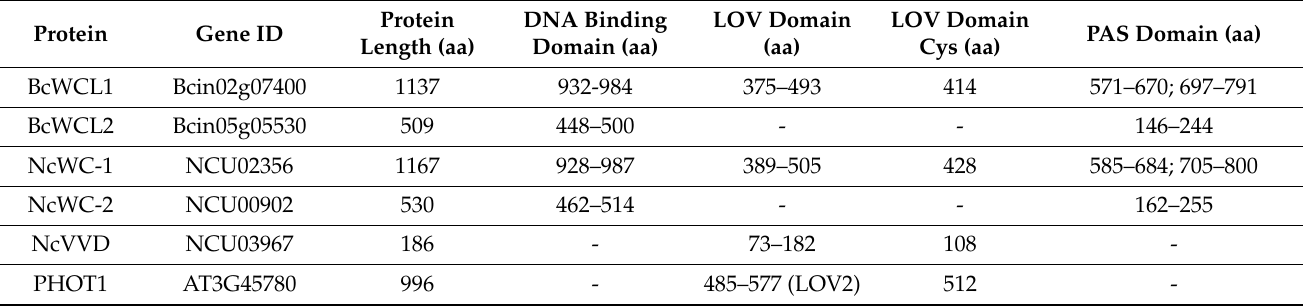
Table 1. Position of the protein domains in BcWCL1 and BcWCL2 of B. cinerea and its orthologous in N. crassa . The position of each domain was predicted using the InterPro Scan tool [34]. The cysteine (Cys) position within the LOV domain was obtained through a protein alignment. For compar- ative purposes, the NcVVD and PHOT1 photoreceptors of N. crassa and A. thaliana , respectively, were